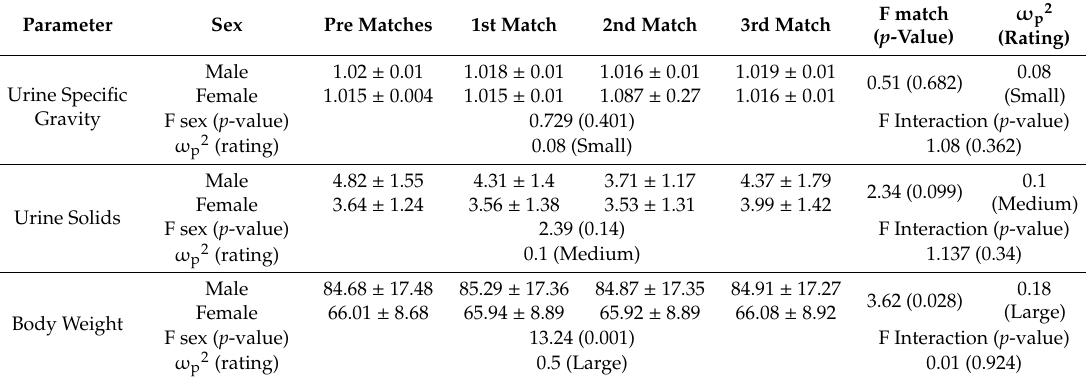
Table 3. Change of hydration status variables between matches by